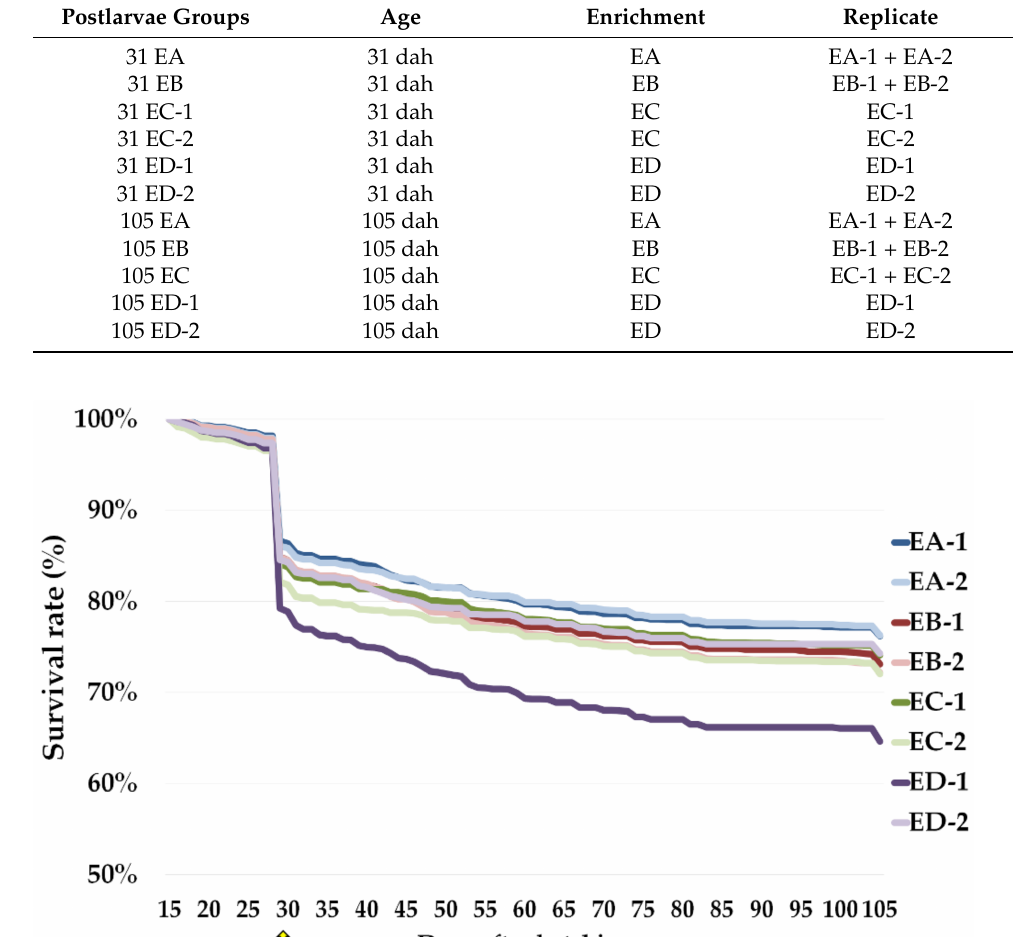
Table 6. Postlarvae diet-tank groups considered for survival, measurements, and skeletal evaluation. dah: days after hatching.